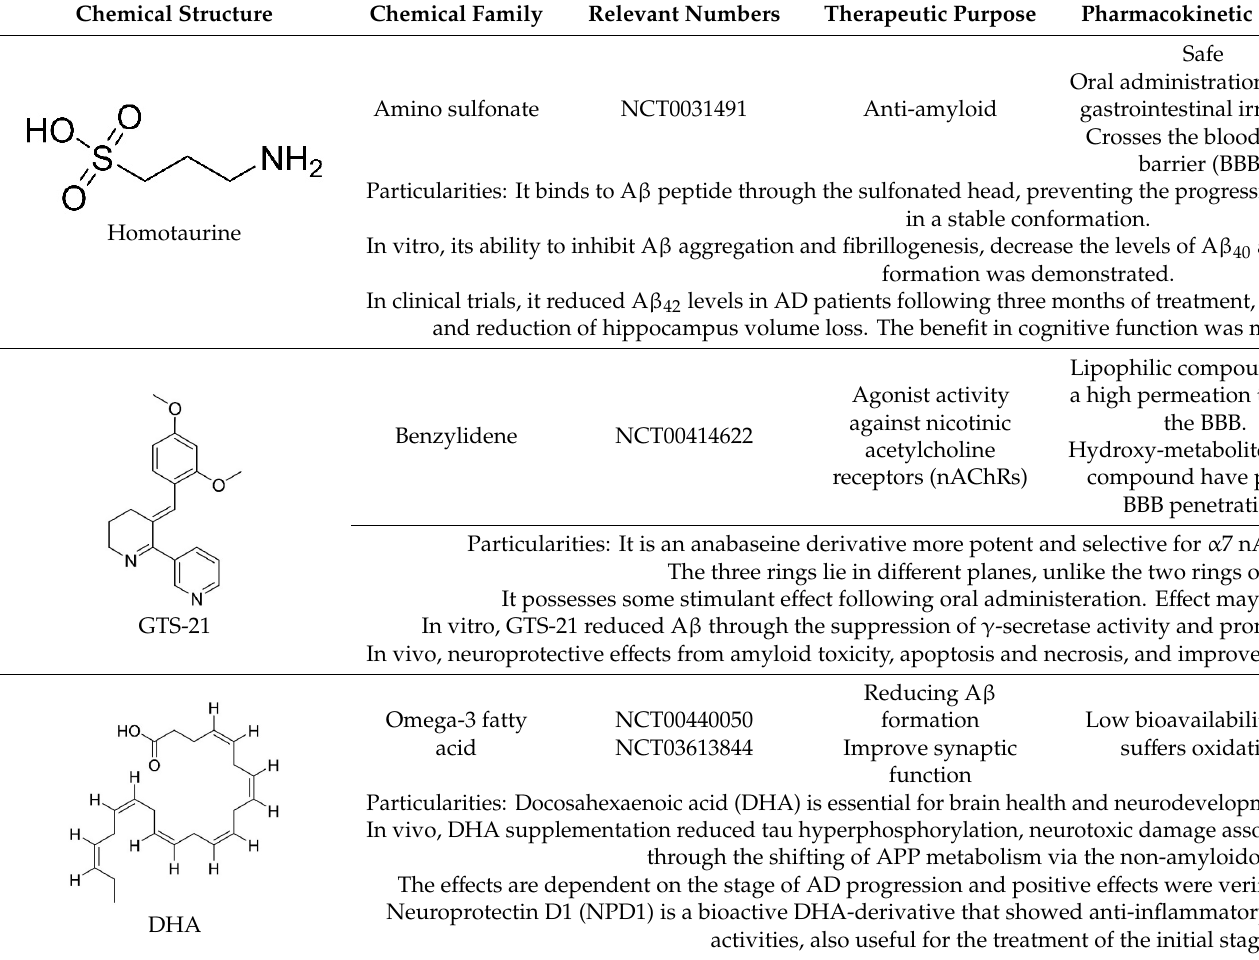
Table 1. List of the main properties of marine natural products and derivatives in the pipeline for AD treatment.